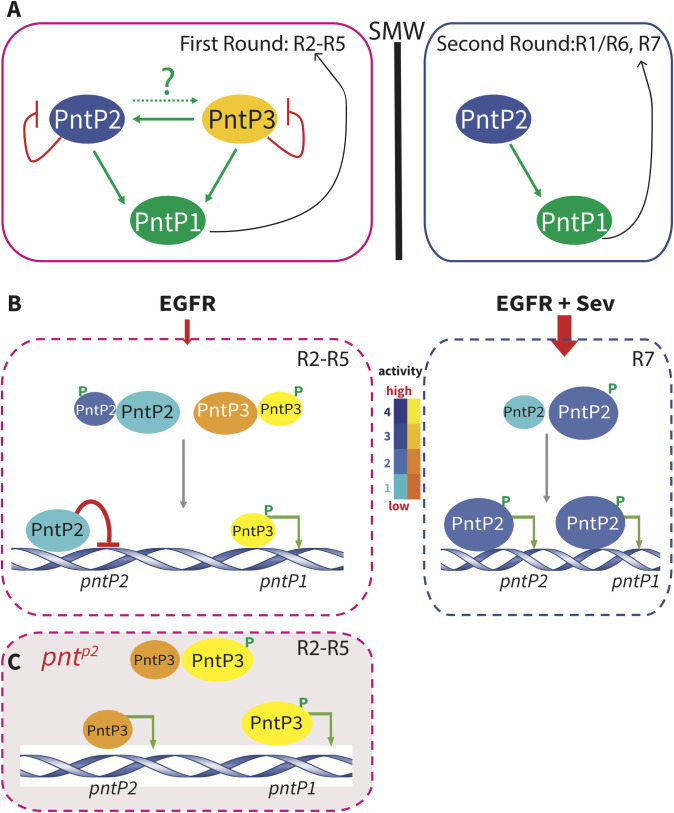
Model: Context-specific topology and function of the Pnt network.(A) A schematic summary of the Pnt network. During first-round specification, both PntP2 and PntP3 auto-repress their transcription, PntP3 activates pntP2, and PntP2 and PntP3 redundantly activate pntP1. During the second-round, PntP2 auto-activates its own transcription and activates pntP1; PntP3 does not contribute. (B) Proposed Pnt network functions in the different signaling environments of first and second round specifications. The color scheme illustrates the range of transactivation activity: for PntP3, yellow indicates high activity and orange low; for PntP2 dark blue indicates high activity and light blue low. As depicted for PntP2, the low transactivation potential of the unphosphorylated forms may allow the proteins to operate as transcriptional repressors. Different sized ovals depict relative abundance of the phosphorylated versus unphosphorylated forms. See Discussion for details.